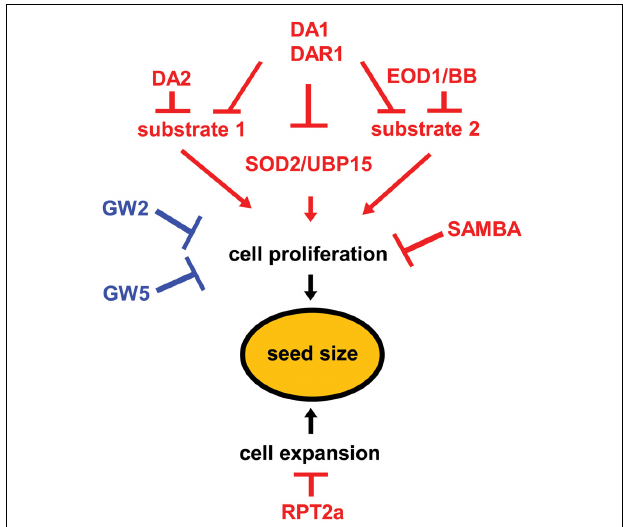
FIGURE 1 | A genetic and molecular framework for ubiquitin-mediated control of seed size. DA1 and DAR1 act redundantly to restrict cell proliferation. DA1 and DA2 may control cell proliferation by suppressing a common substrate (substrate 1). Similarly, DA1 and EOD1 may regulate cell division through a common target (substrate 2). DA1 acts upstream of UBP15 and modulates its stability to control cell proliferation. GW2, GW5 and SAMBA control seed size by restricting cell proliferation, respectively. RPT2a regulates seed size by limiting cell expansion. The seed size regulators in Arabidopsis and rice are shown as red and blue,